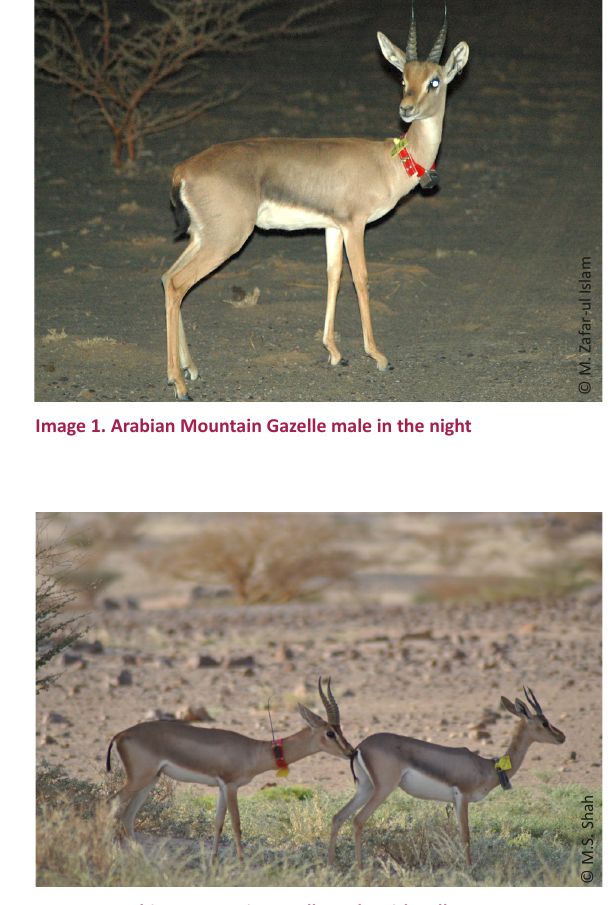
Image 3. Arabian Mountain Gazelle male with collars